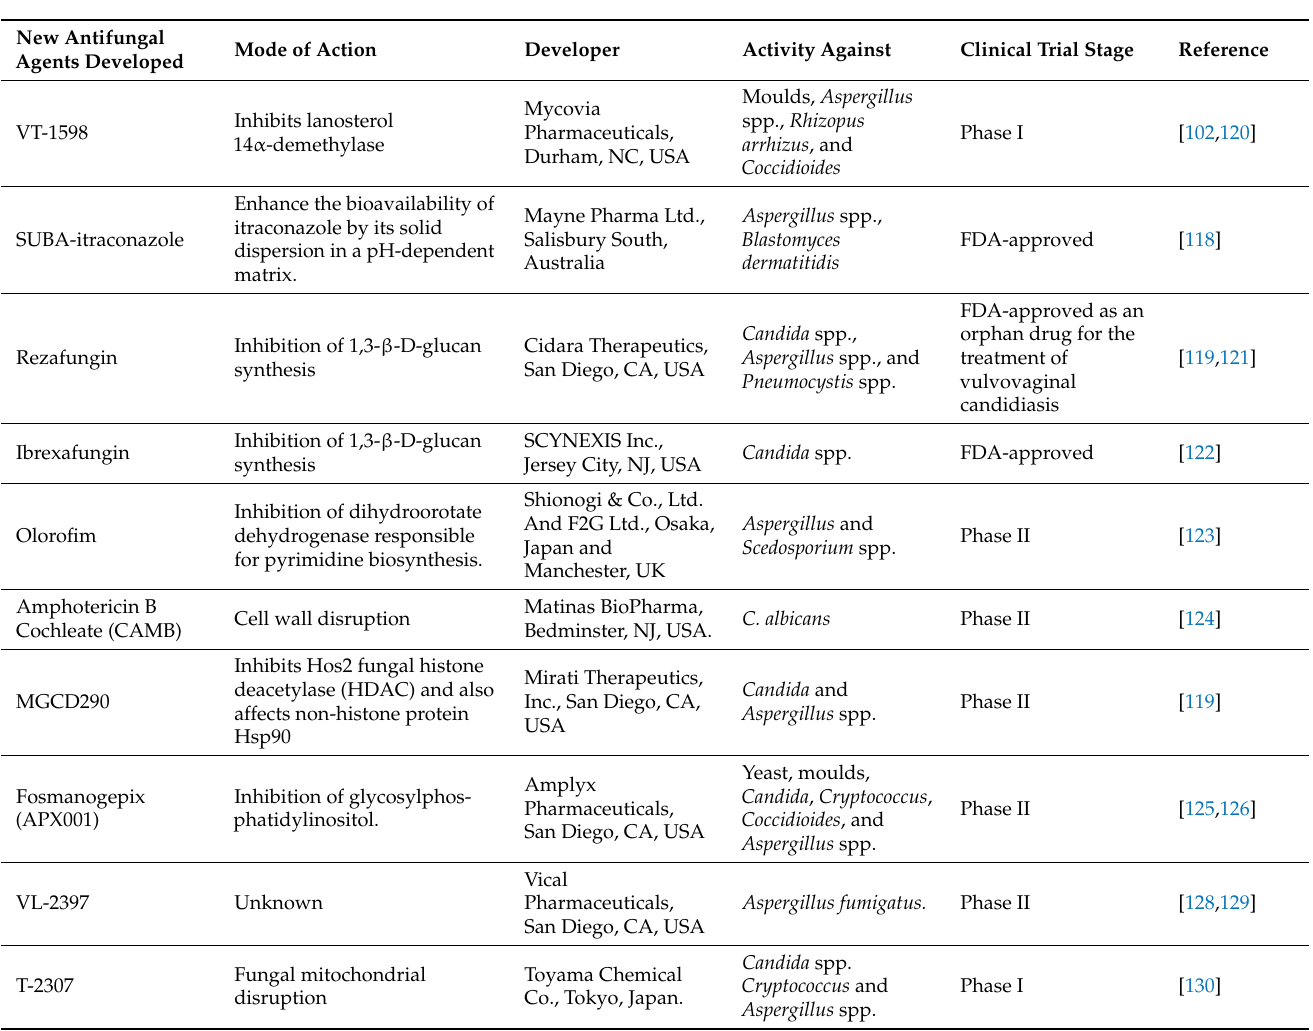
Table 2. List of new antifungal